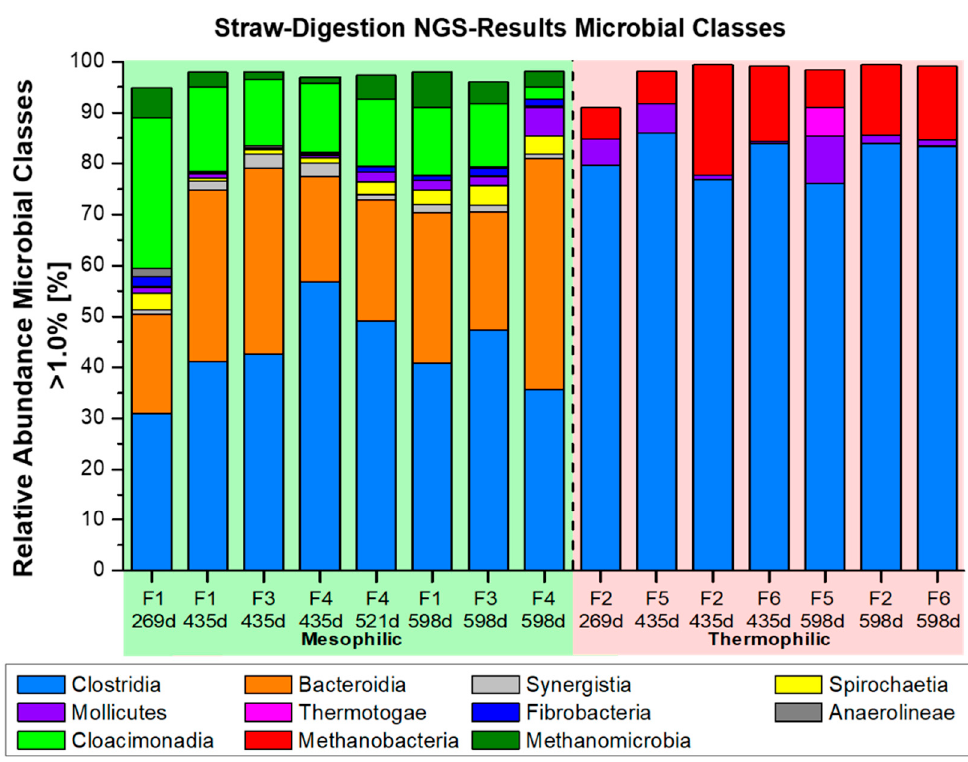
Figure 6. Relative abundance of the most important microbial classes, with an abundance of >1.0% (major players), which were recorded by NGS analysis in the different mesophilic and thermophilic wheat straw fermenters F1–F6 (Figure 1B) with ‘synthetic manure’ as defined medium.